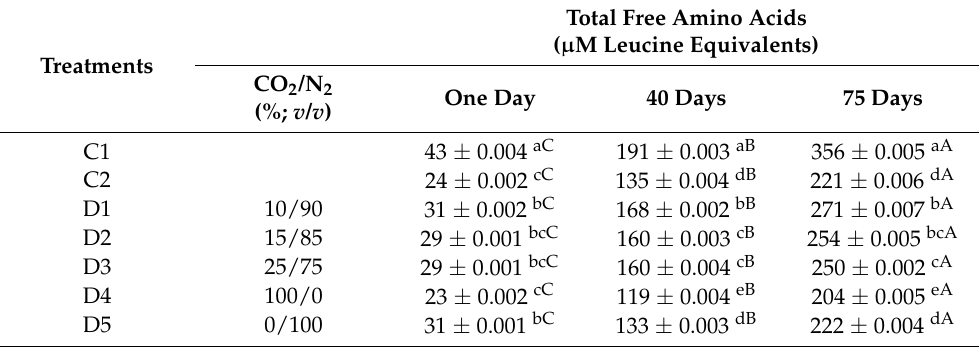
Table 2. Total free amino acids levels (means ± SE) in cheese packaged under different modified atmospheres (CO 2 and N 2 ) during